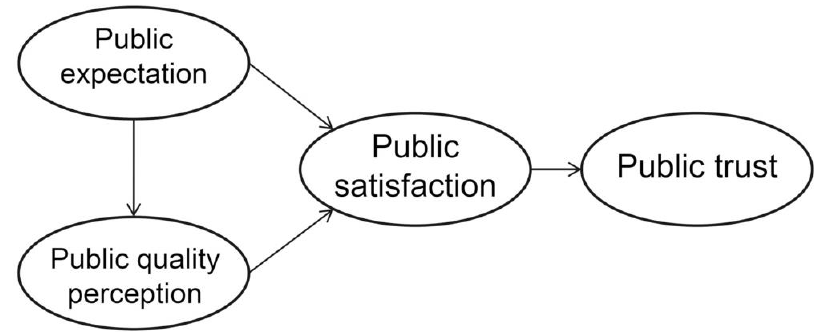
Figure 3. Framework of EPST model. (Source: the authors).